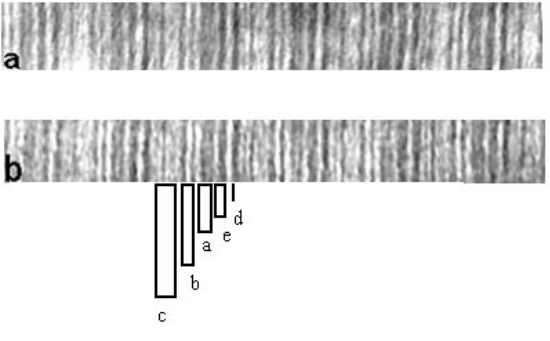
FIGURE 6. Positive staining patterns from sections of rabbit liver collagen. The sections were doubly stained with phosphotungstic acid and uranyl acetate. In (a), the staining pattern is from collagen treated with 1.5 meq Li/kg. Animals were sacrificed 1 day after the end of treatment. (b) Normal staining pattern. Both patterns are at the same magnification. Labelling of the bands follows the notation of Hodge and Schmitt[68]. ×